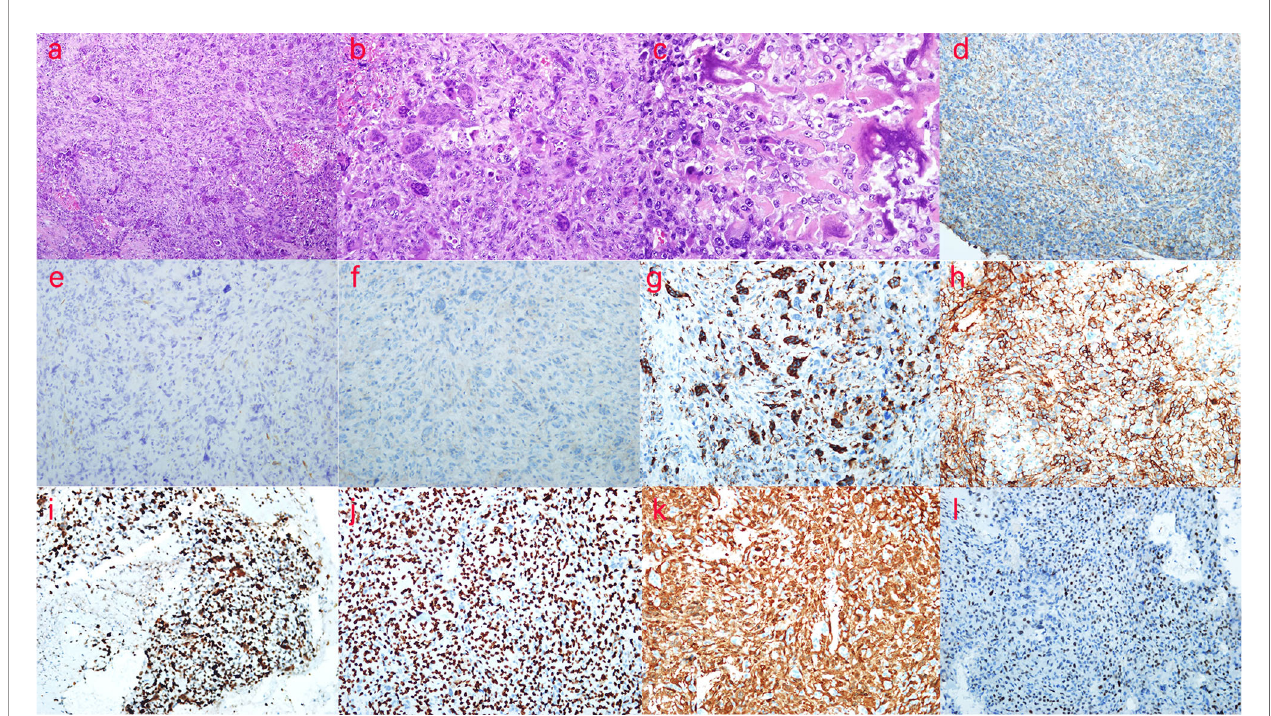
FIGURE 4 | Pathological examination and immunohistochemistry (IHC) of the patient. (A) H&E, ×100, the tumor cells grew diffusely in sheet form, with parts arranged in a slightly weave-like manner, in which multinucleated giant cells were scattered and small areas of necrosis were seen. (B) H&E, ×200, osteoclast-like multinucleated giant cells were scattered in tumor cells. (C) H&E, ×400, lace- or grid-like tumor osteogenesis is observed. (D) b -Catenin (++), ×200, the tumor cell membrane in b -catenin was positive. (E) SMA ( − ),×200; (F) CD99 ( − ), ×200; (G) CD68 (+), ×200; positive expression of cytoplasmic CD68 was found in osteoclast- like giant cells. (H) BCL-2 (++), ×200; (I) Ki-67 (50%+), ×200; the proliferation index of Ki-67 was 50%. (J) SATB-2 (++), ×200; SATB-2 showed diffuse positive expression in the tumor nucleus. (K) P16 (++), ×200; P16 showed diffuse positive expression in the tumor; (L) MDM-2 (+), ×200; MDM-2 was positive in parts of the tumor cells. According to the above description, the patient was diagnosed with primary extraskeletal